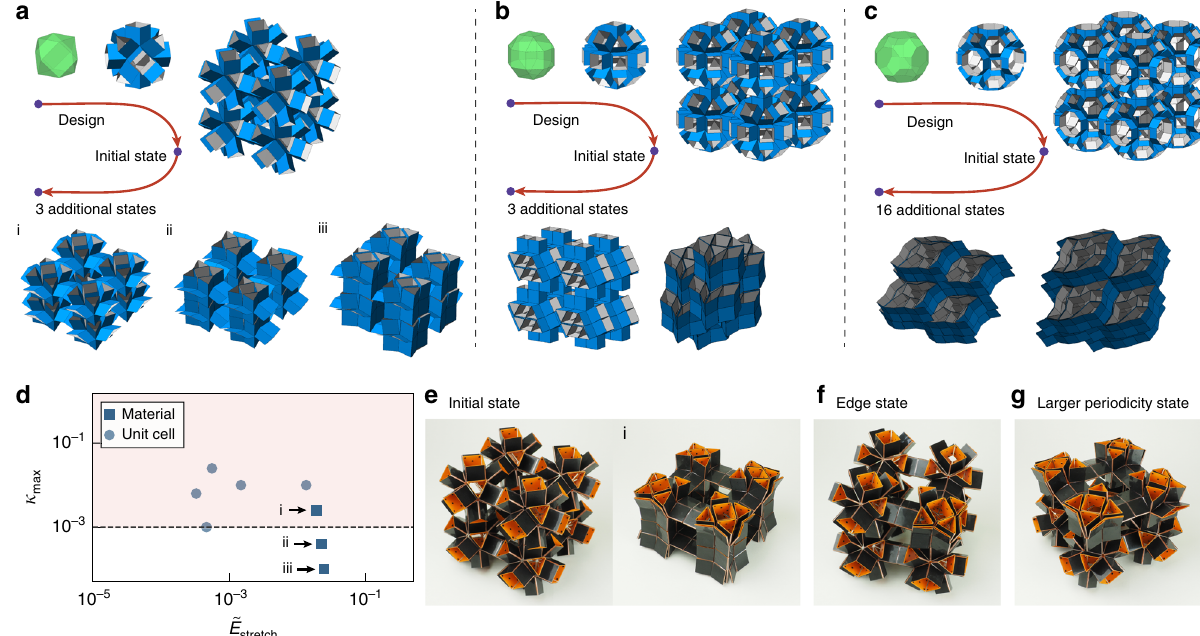
Fig. 5 Simulations and experiments of multistable metamaterials. The simulated metamaterials are based on cubic tesselations of prismatic structures based on a a cuboctahedron, b a rhombicuboctahedron and c a truncated cuboctahedron. d Normalized stretch energy ( ~ E ratio ( κ ) for the unit cell and metamaterial based on a cuboctahedron. e One of the stable states of the prismatic structure based on a cuboctahedron max found in simulations can also be achieved in a prototype of the metamaterial made with 50 µ m thick Mylar hinges. Additionally, we fi nd f edge and corner states and g stable states with periodicity larger than a single unit cell not covered by our